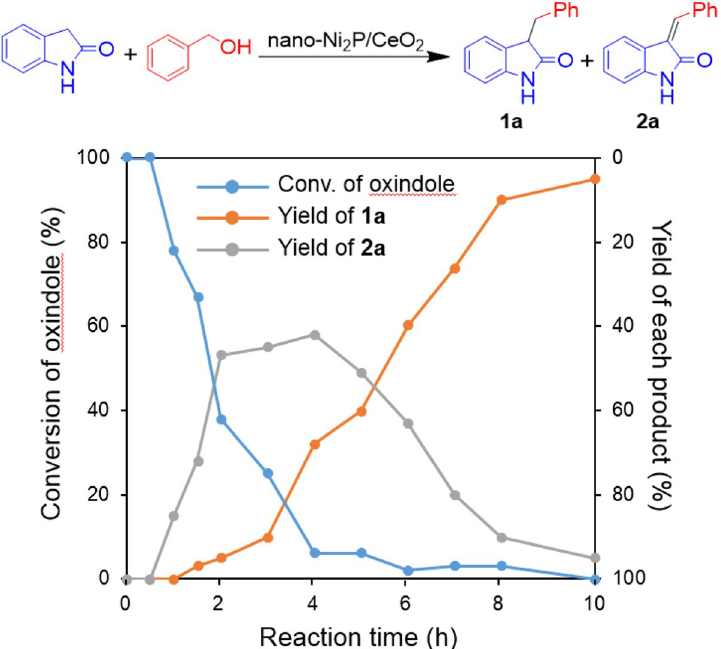
Figure 3. Reaction profile for the C-3 alkylation of oxindole with benzyl alcohol catalyzed by nano-Ni 2 P/CeO 2 . Reaction conditions: nano-Ni